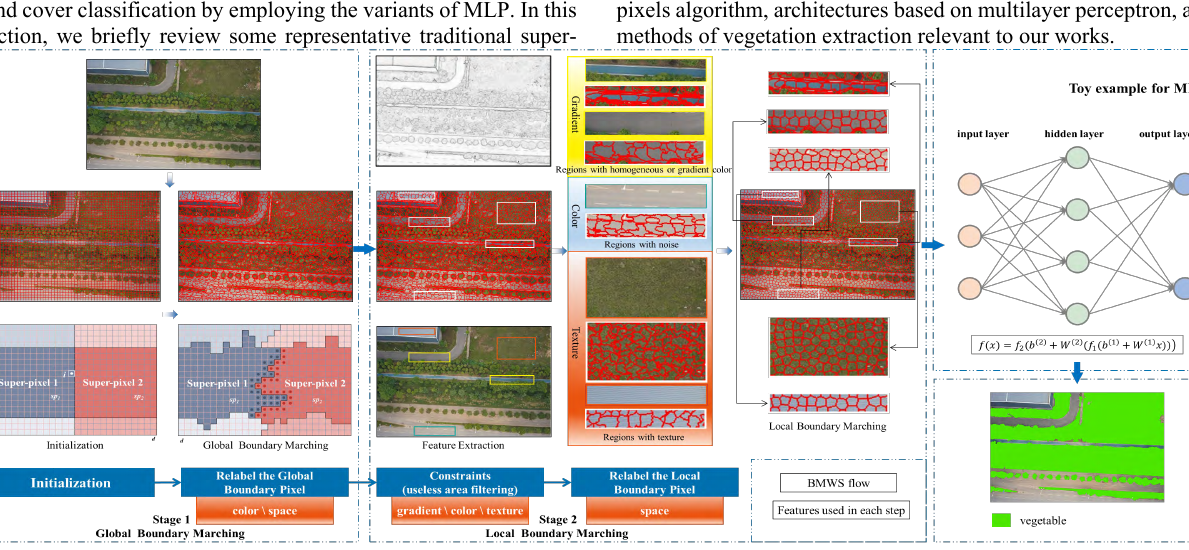
Figure 1. Working flowchart of the proposed hybrid solution for vegetation detection.